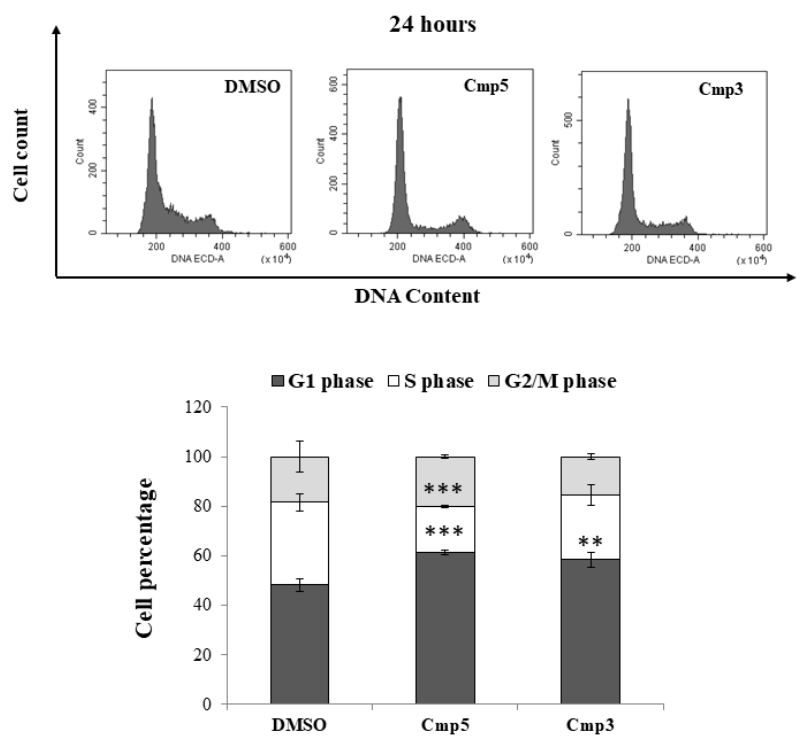
Figure 5. Cell cycle analysis in C6 rat glioma cells in the presence of Cmp 5 and Cmp 3 . The upper panel displays the di ff erent DNA profile of cells after a 24 h treatment. Peaks are generated by the emission of PI in the FL3 fluorescence channel. The percentage of cells in the G1, S and G2 phases are shown in the bar graph in the lower panel. Bars represent medians ± SD from three independent experiments. *** p < 0.002 between G1 phase of DMSO and Cmp 5 ; *** p < 0.002 between S phase of DMSO and Cmp 5 ; ** p < 0.02 between G1 phase of DMSO and Cmp 3 .